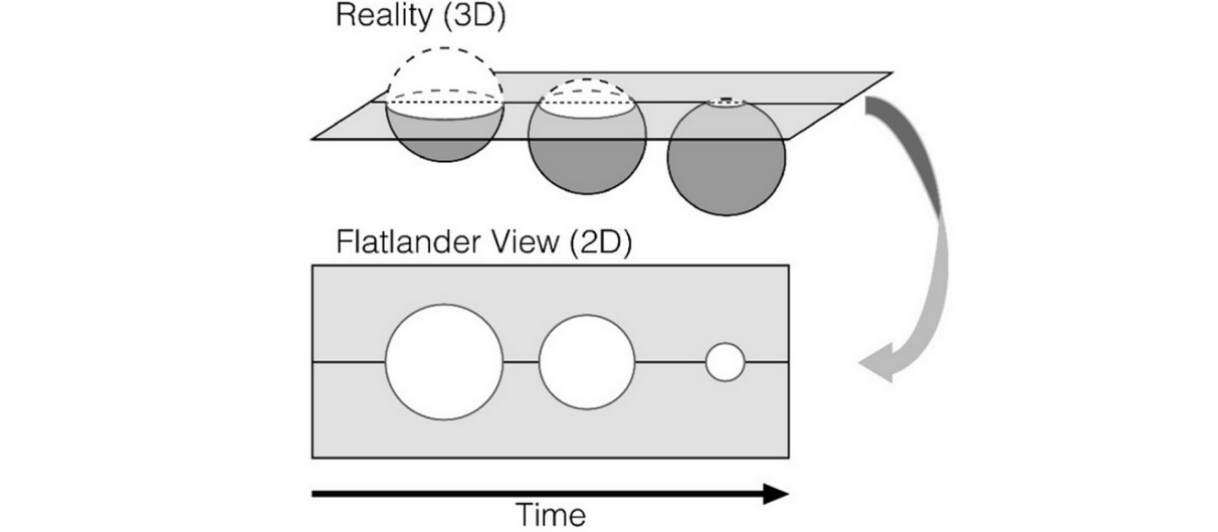
Figure 1. A Square cannot perceive his world as anything other than 2-dimensional. Reprinted with